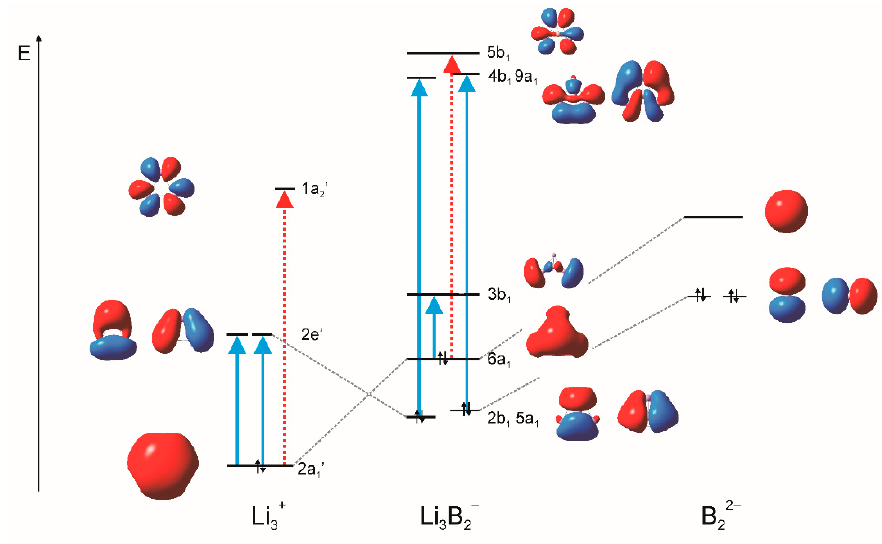
Figure 6. Orbital interaction diagram of Li 3 B 2 − obtained at the M06-2X/def2-TZVP level of theory. Full (blue) arrows represent the main translational transitions, and dashed (red) arrows represent the main rotational transitions.